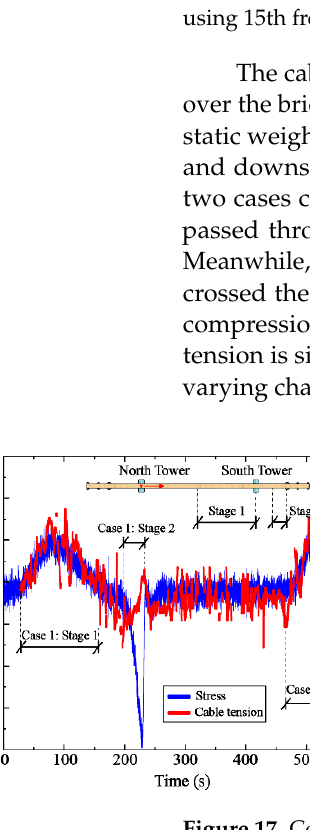
Figure 17. Comparison of cable tension to ( a ) stress and ( b ) GPS displacement.